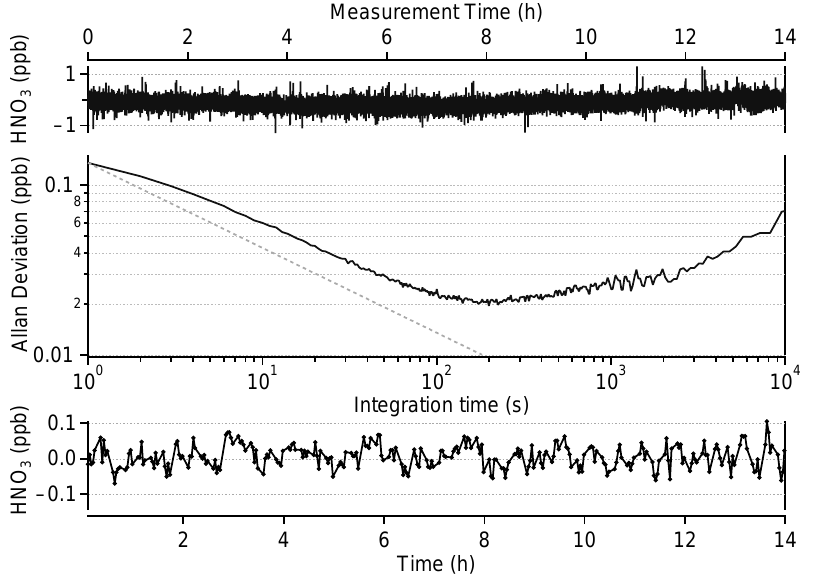
Figure 4. Top :HNO -free air measurement with a resolution of 1s over 14h. Middle : corresponding 3 Allan–Werle deviation plot. Bottom : 2 min averaged zero-drift-corrected